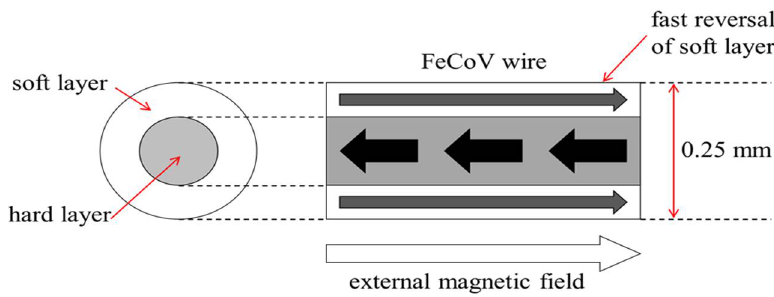
Figure 1. Schematic drawing of magnetic structures of the FeCoV wire.